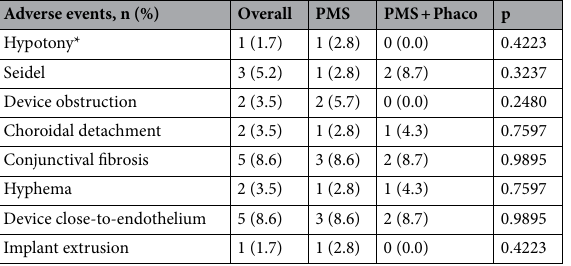
Table 3. Adverse events observed or reported during the study follow-up. *Defined as an intraocular pressure < 6 mmHg during at least 4 weeks. PMS Preserflo